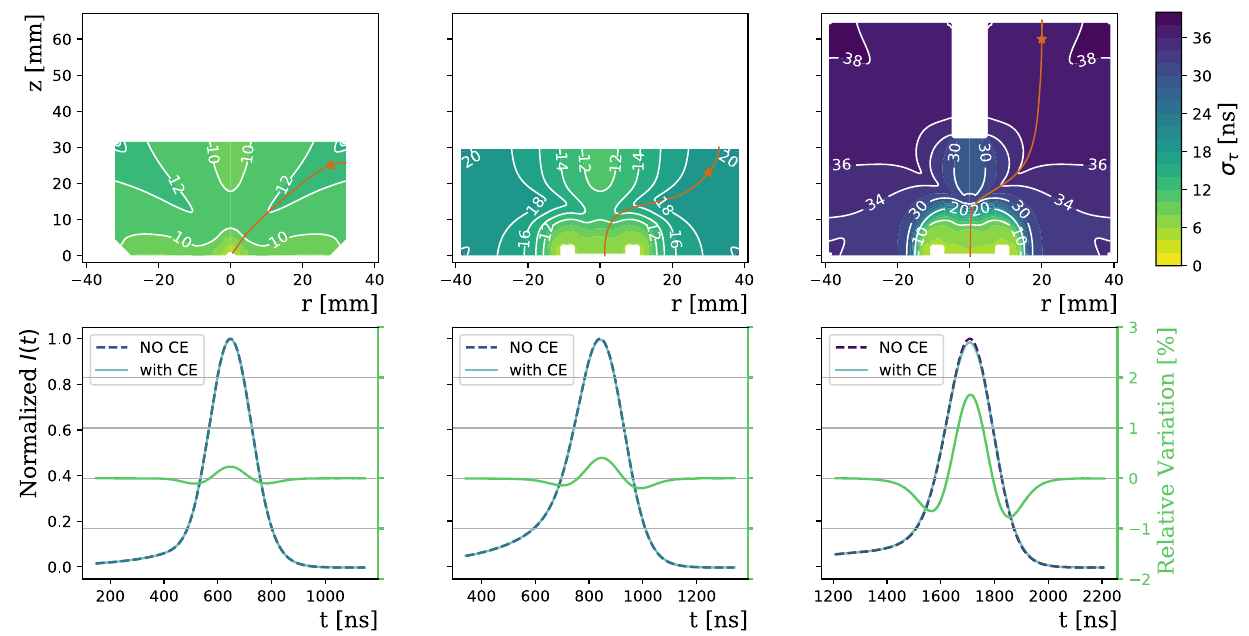
Fig. 3 Top: values of the σ τ parameter as a function of the interaction position, for the three geometries considered. Bottom: simulated sig- nals for the interactions and drift paths indicated by the brown point and